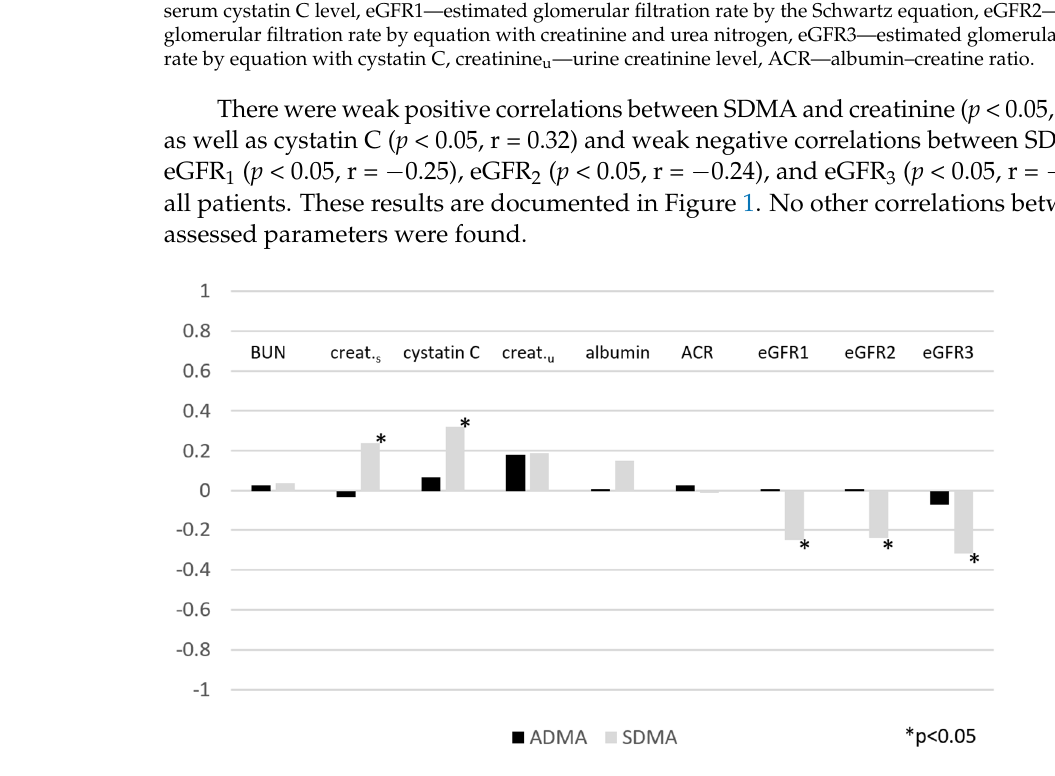
Figure 1. Spearman’s rank correlation coefficient for the studied parameters; ADMA-asymmetric dimethylarginine, SDMA-symmetric dimethylarginine, BUN-blood urea nitrogen, creat. s -serum creatinine level, cystatin C-serum cystatin C level, creat. u -urine creatinine level, ACR-albumin–creatine ratio, eGFR1-estimated glomerular filtration rate by the Schwartz equation, eGFR2-estimated glomerular filtration rate by equation with creatinine and urea nitrogen, eGFR3-estimated glomerular filtration rate by equation with cystatin C.